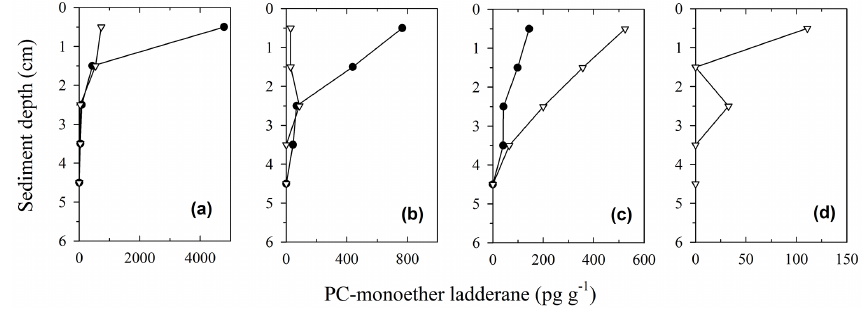
Figure 4. Abundance profiles of PC-C 20 -[3]-ladderane monoether (pgg − 1 sediment dry weight) as a function of depth at GOB1 (a) , GOB2 (b) , GOB3 (c) , and RA2 (d) . Black dots represent values from 2013, while white triangles represent values from 2014. Please note different scales on the x